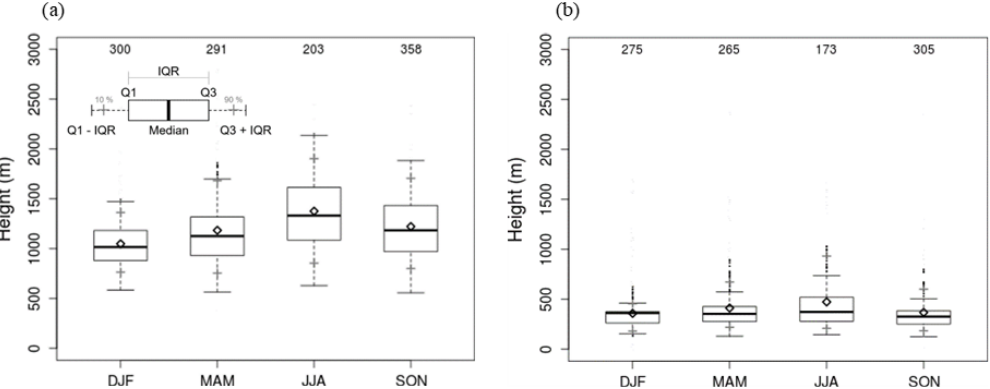
Figure 14. Box plot of seasonal ABLH during the (a) daytime (14:00 to 16:00LST) and (b) nighttime (03:00 to 05:00LST) for the period